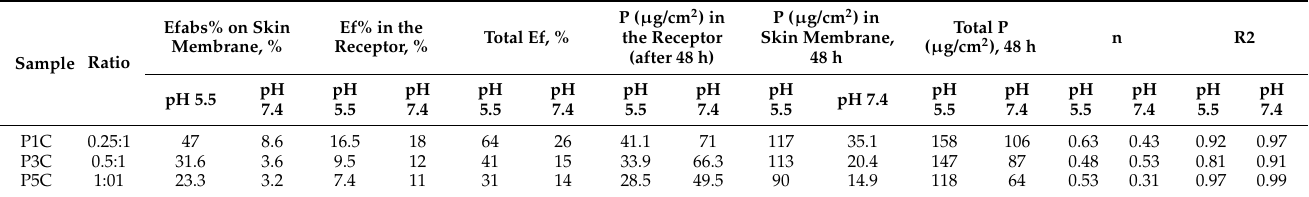
Table 1. The release efficiency and permeability of curcumin-loaded in hydrogel films through the skin membrane. Efabs% on Skin Membrane, Sample Ratio